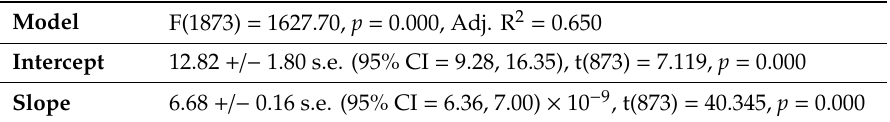
Table 6. Characterization of the regression model relating the abundance ratio 16S rRNA / Hsp70 (dependent variable) to the Hsp70 abundance (independent variable).